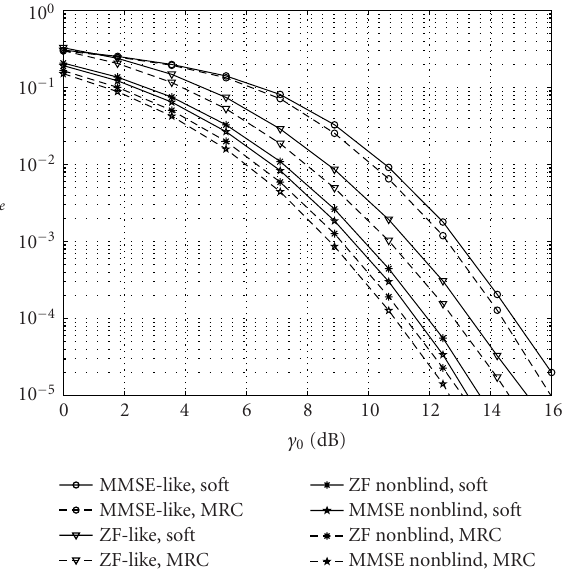
Figure 11: Probability of error for the blind receivers; cooperative reception scheme: K = 4, M = 8, N = 4, n t = 2, n r = 2, Q = 1300, and P = 1500.